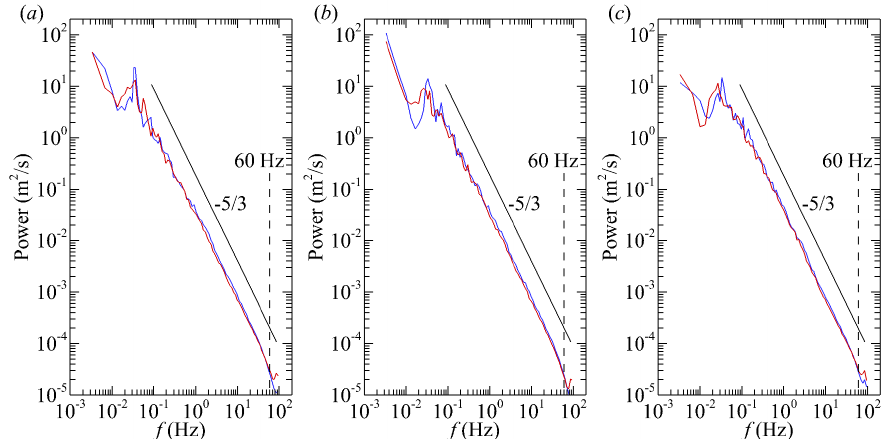
Figure 14. Frequency spectra measured during flight 3 for ( a ) U 1 component of velocity, ( b ) U 2 component of velocity, and ( c ) U 3 component of velocity. The blue lines correspond to spectra measured by BC5A and the red lines correspond to spectra measured by BC5B. The solid black line indicates a − 5/3 power law decay and the vertical dashed line indicates the measured frequency response of the